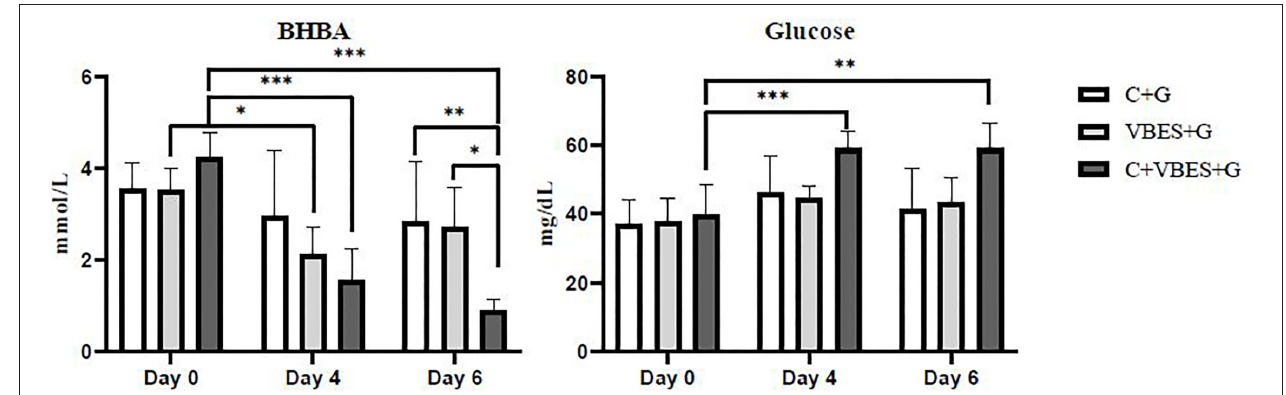
FIGURE 2 | BHBA and glucose concentrations by group and time. The BHBA and glucose concentration were measured on the pre-treatment day (Day 0), and on 1 day (Day 4) and 3 days (Day 6) after the last treatment day. C + G = levocarnitine and glycerin, VBES + G = vitamin B complex, vitamin E with selenium, and glycerin,